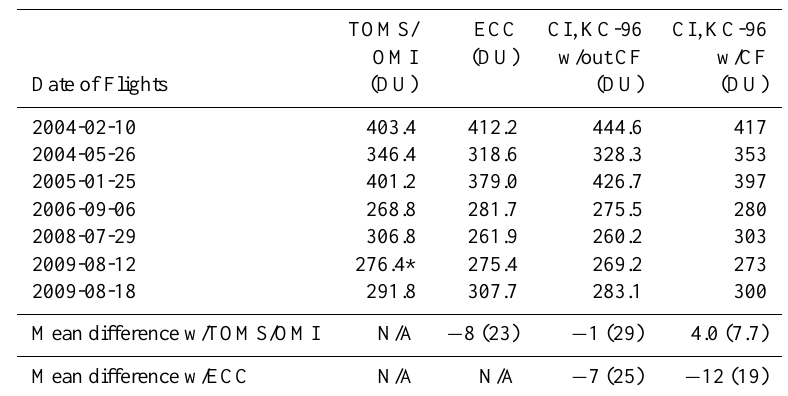
Table 8. Column ozone amounts for Earth Probe TOMS (EPTOMS) or Ozone Mapping Instrument (OMI), electrochemical concentration cell (ECC) ozonesondes launched at Hokkaido University, and the Carbon Iodine ozonesondes launched at Sapporo both without and with correction factors applied. Mean differences between the sonde columns and TOMS/OMI columns are shown, with 1 σ in parenthesis. Mean differences of the CI columns with and without the correction factors (CF) applied are shown relative to the ECC columns, with 1 σ in parenthesis. For the flight of 2009-08-12 (marked *), no OMI overpass is available, so the overpasses from the prior and next day are averaged.